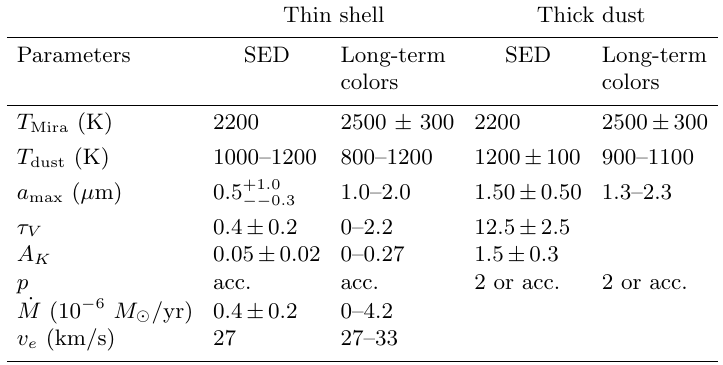
Table 1. Modeled circumstellar dust properties around the Mira component of RR Tel ( a max { maximum grain size; (cid:28) V { visual optical depth; A K { the extinction in K band; p { power index in dust density distribution law (acc. for dust density enhanced by radiatively driven winds), _ M { mass-loss rate; v e { terminal wind velocity). Thin shell Thick dust Parameters SED Long-term SED Long-term